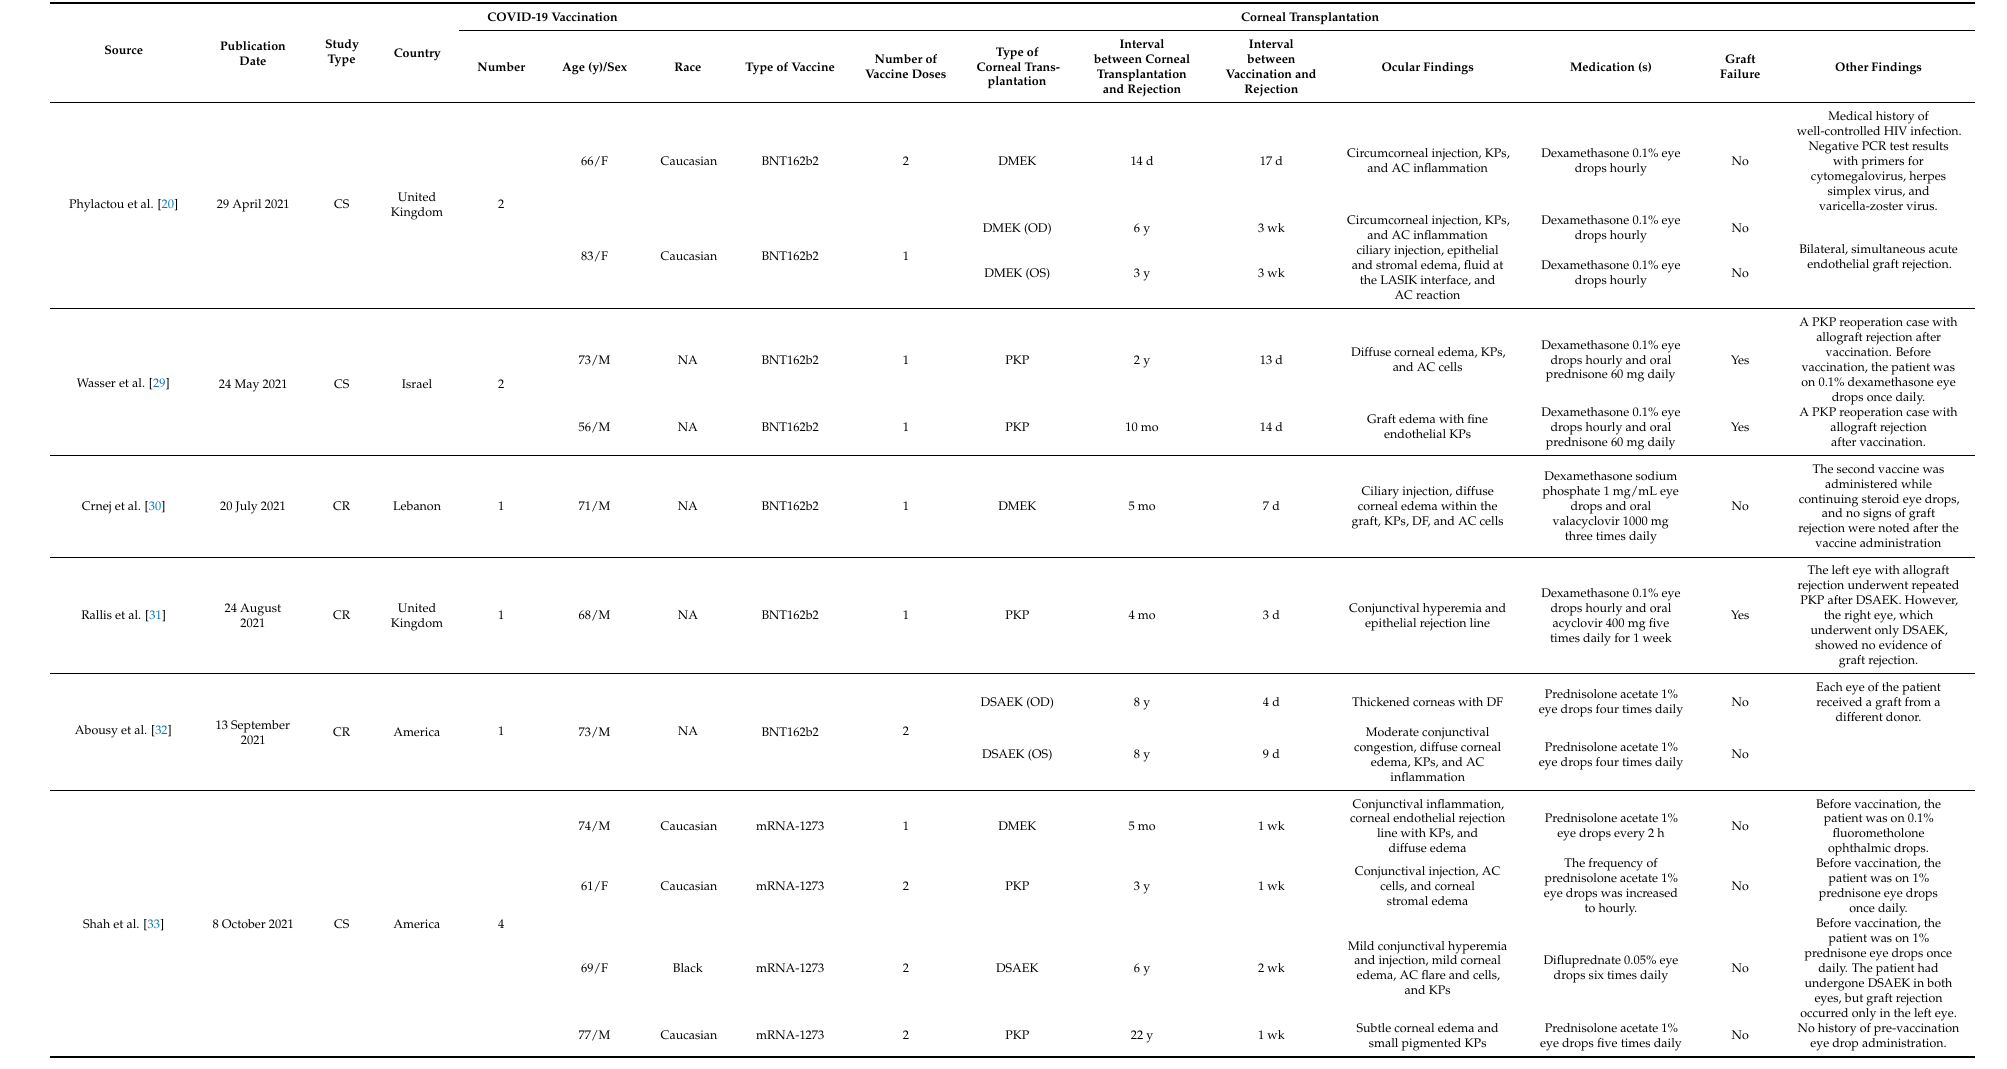
Table 3. Characteristics of the included